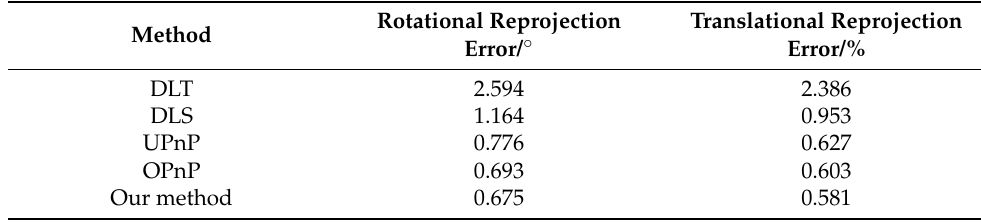
Table 8. Pose calculation